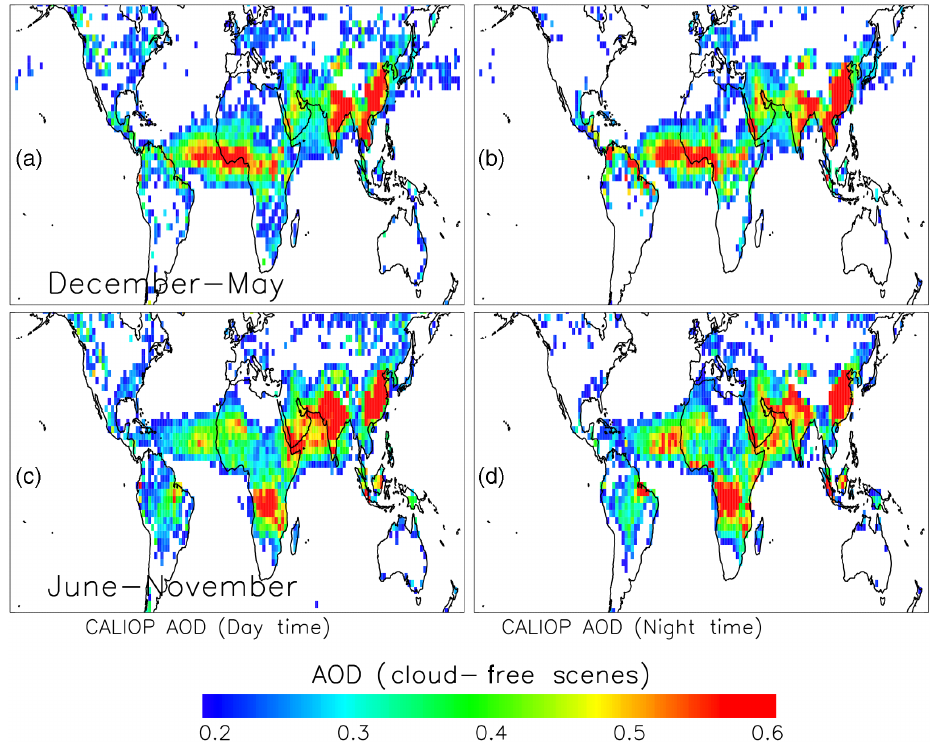
Figure 7. Multi-year (2006–2013) 2.5 ◦ × 2.5 ◦ averaged CALIOP daytime AOD for (a) December through May over completely cloud- free scenes derived from CALIOP cloud and aerosol layer daytime analysis, (b) nighttime analysis during the December to May period, (c) daytime analysis for the June to November period, and (d) nighttime analysis for the June to November period. Only scenes which contained an averaged AOD>0.2 with a column COD = 0 were used in the